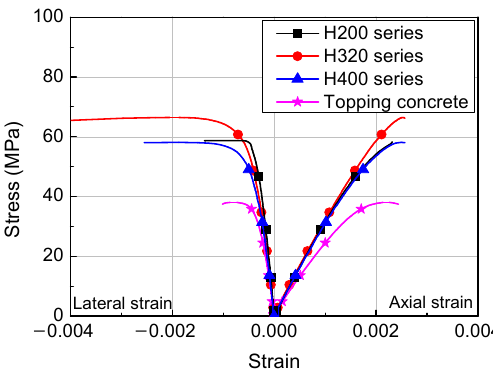
Figure 2. Stress-strain relationships of